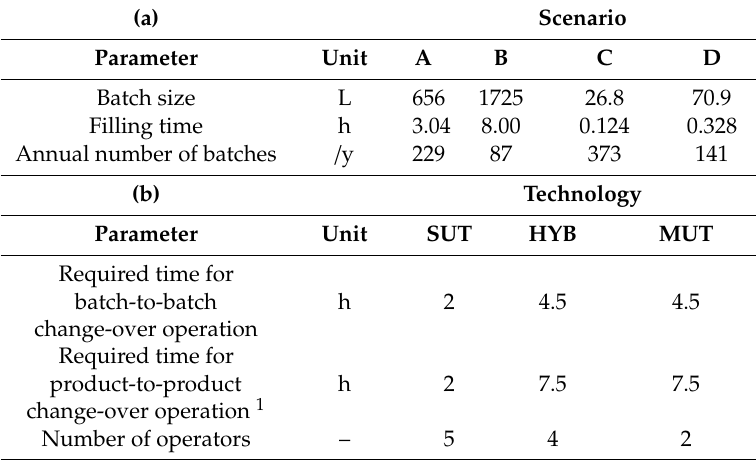
Table 5. Parameters of the operating conditions decision layer of di ff erent ( a ) scenarios (intermediate calculation results) and ( b ) technologies (default values from the